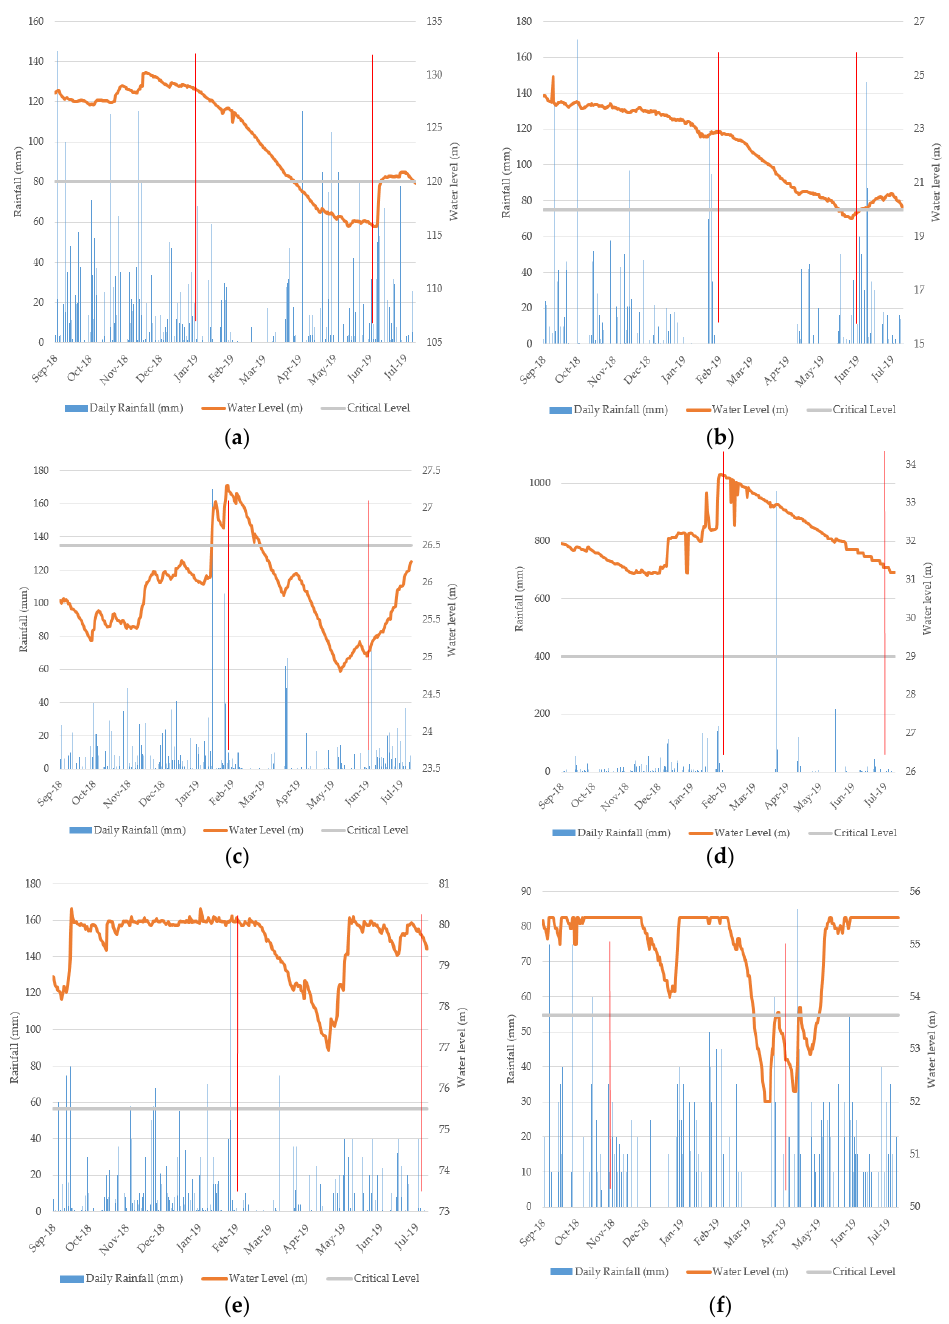
Figure 1. Water levels in meters (m) during the specific drought period denoted with red vertical lines for each of the major water dams in each region: West Coast ( a , b ); Northeast Coast ( c , d ); Southeast Coast ( e , f ).